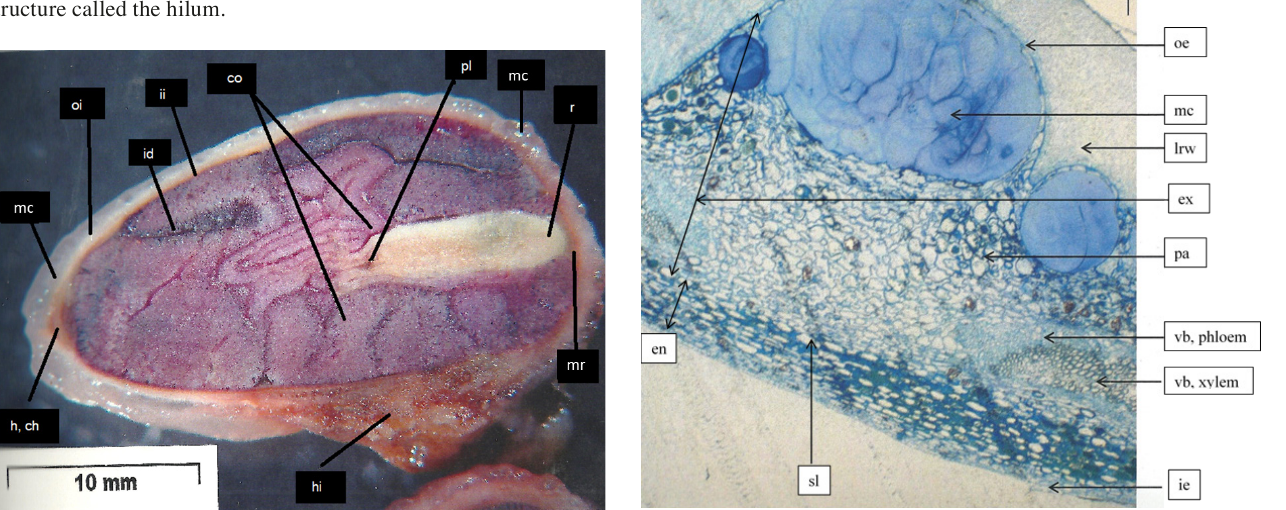
Fig. 1: Longitudinal section of a cacao seed: after pectinase treatment fruit pulp has been removed and testa associated mucilage has taken up water and covers the testa as a continuous layer. The hypostasis (h), chalaza (ch), hypodermal mucilage caverns (mc) outer integument (oi), inner integument (ii), cotyledons (co), plumule (pl), idioblasts filled with flavonoid phenolic compounds (id), radicula (r), micro- pylar region (mr), and hilum (hi).